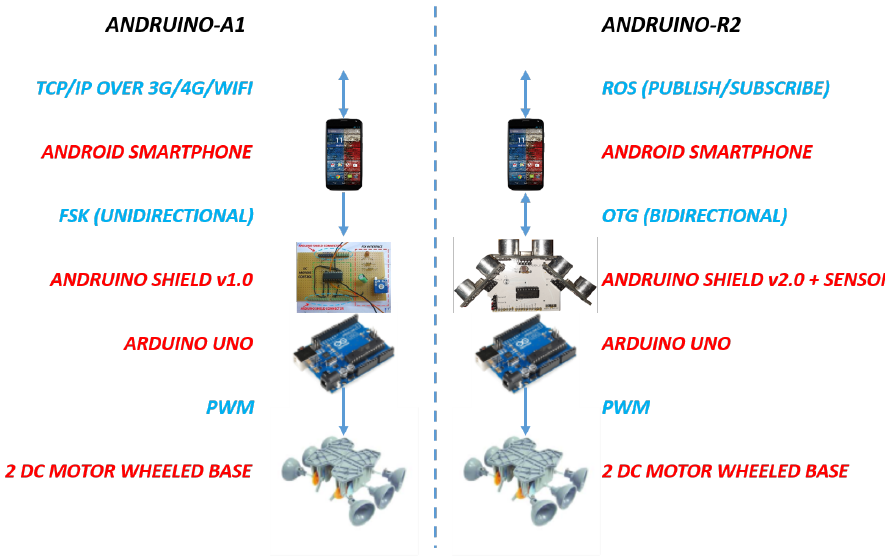
Figure 2. Integration of hardware components in Andruino-A1 and